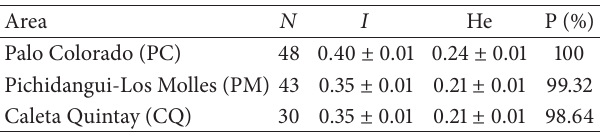
Table 2: Genetic variability parameters obtained from 147 bands in 121 individuals of P. splendens ( 𝑁 : number of individuals sampled per area; 𝐼 : Shannon’s index; He: expected heterozygosity; P (%): percentage of polymorphic